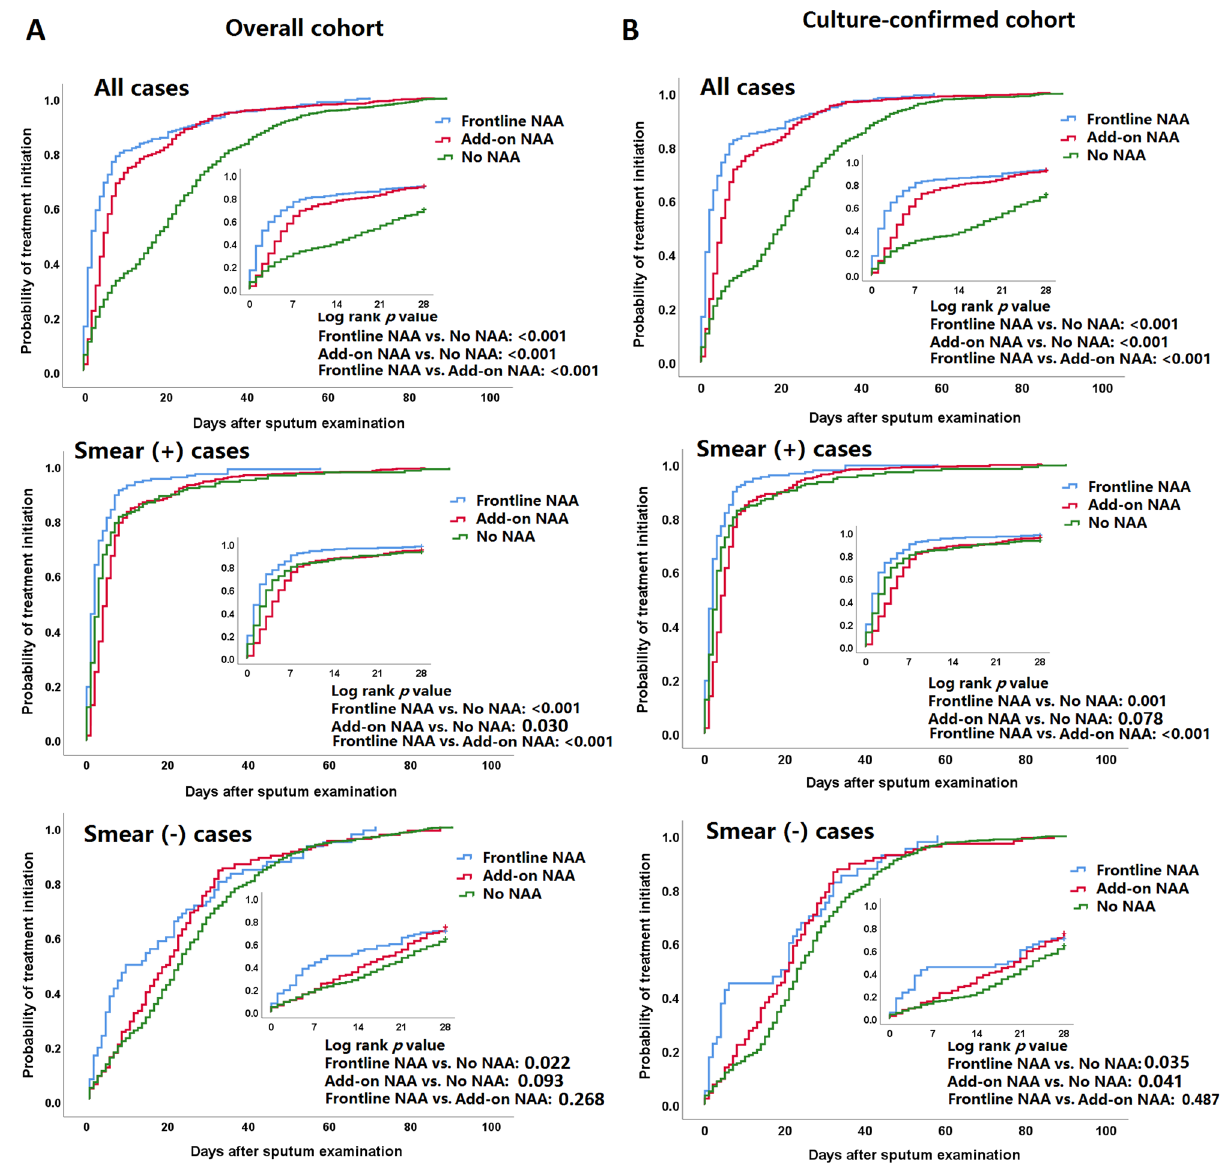
Figure 2. Kaplan–Meier analysis of time to initiation of anti-TB treatment in the ( A ) overall cohort, and ( B ) culture-confirmed cohort. NAA nucleic acid